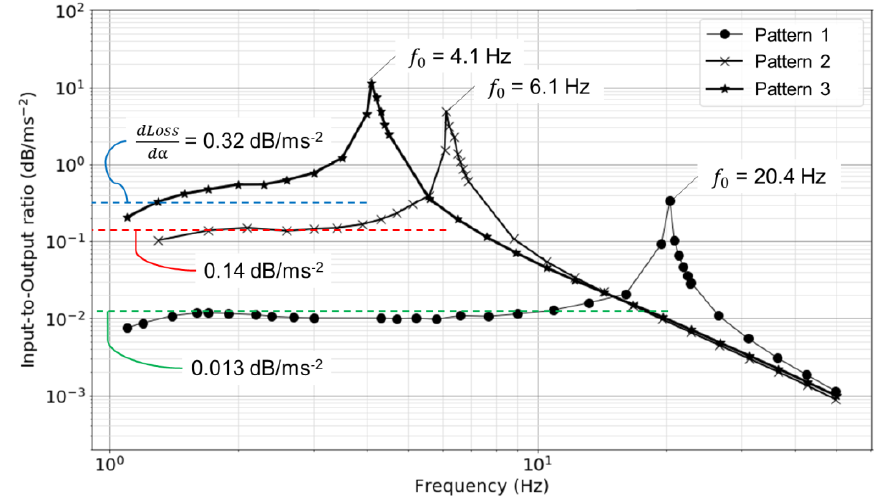
Figure 6. Frequency response characteristics of the proposed accelerometer which was modulated in three patterns shown in Table 1.